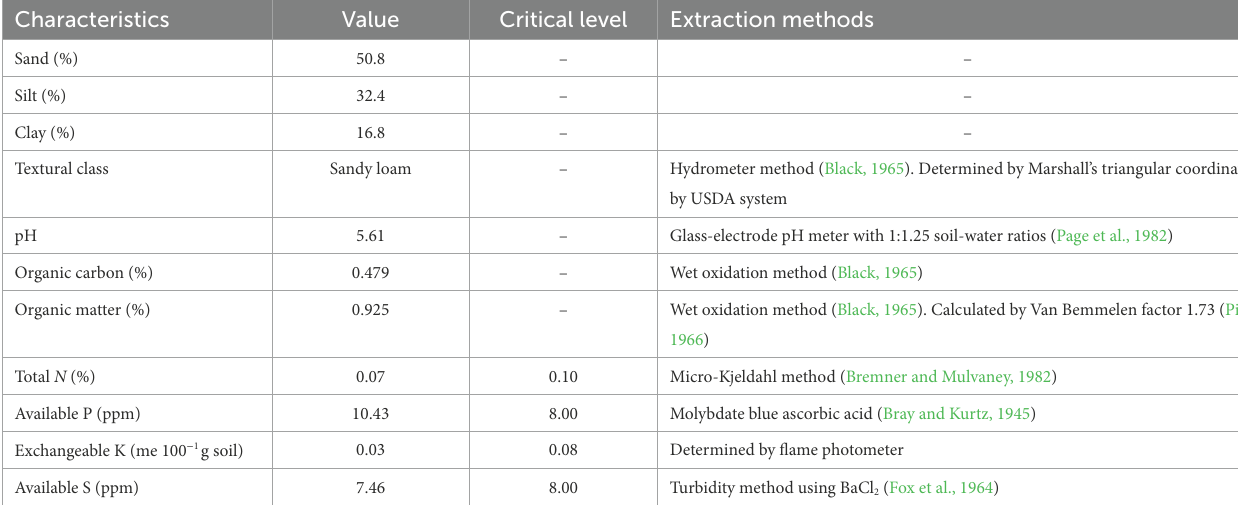
TABLE 2 Physical and chemical properties of the soil used in the experiment.